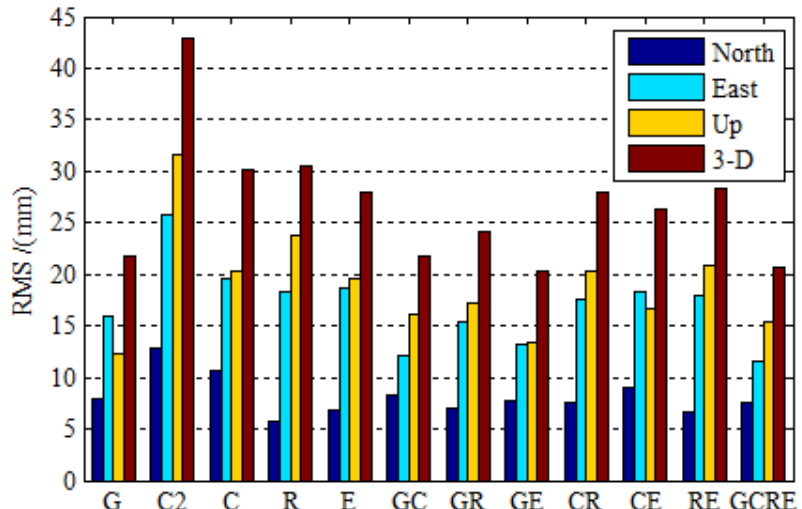
Figure 5. The root mean squares (RMS) error for GPS-only, BDS-2-only, BDS-2 / BDS-3, GLONASS-only, Galileo-only, GPS / BDS-2 / BDS-3, GPS / GLONASS, GPS / Galileo, BDS-2 / BDS-3 / GLONASS, BDS-2 / BDS-3 / Galileo, GLONASS / Galileo, and GPS / BDS-2 / BDS-3 / GLONASS / Galileo static PPP processing using real observation data collected at 16 stations over 30 days.